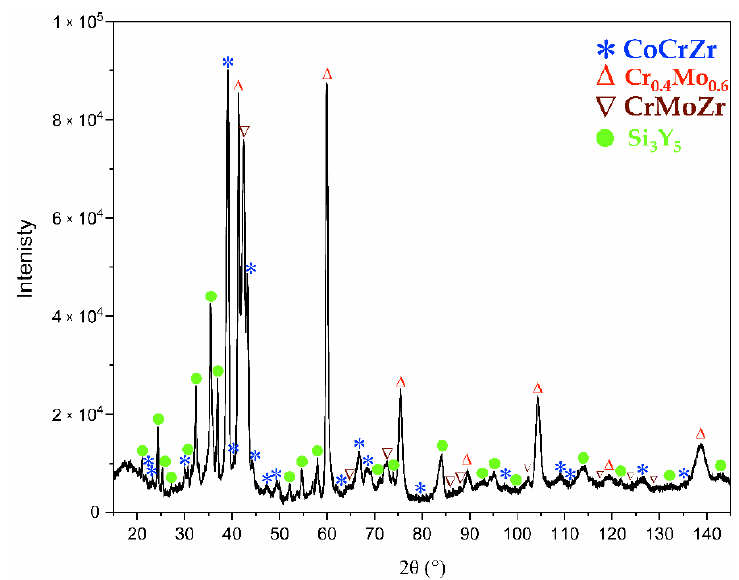
Figure 1. X-ray diffraction pattern for the studied Co 15 Cr 15 Mo 25 Si 15 Y 15 Zr 15 alloy with indexed phases.